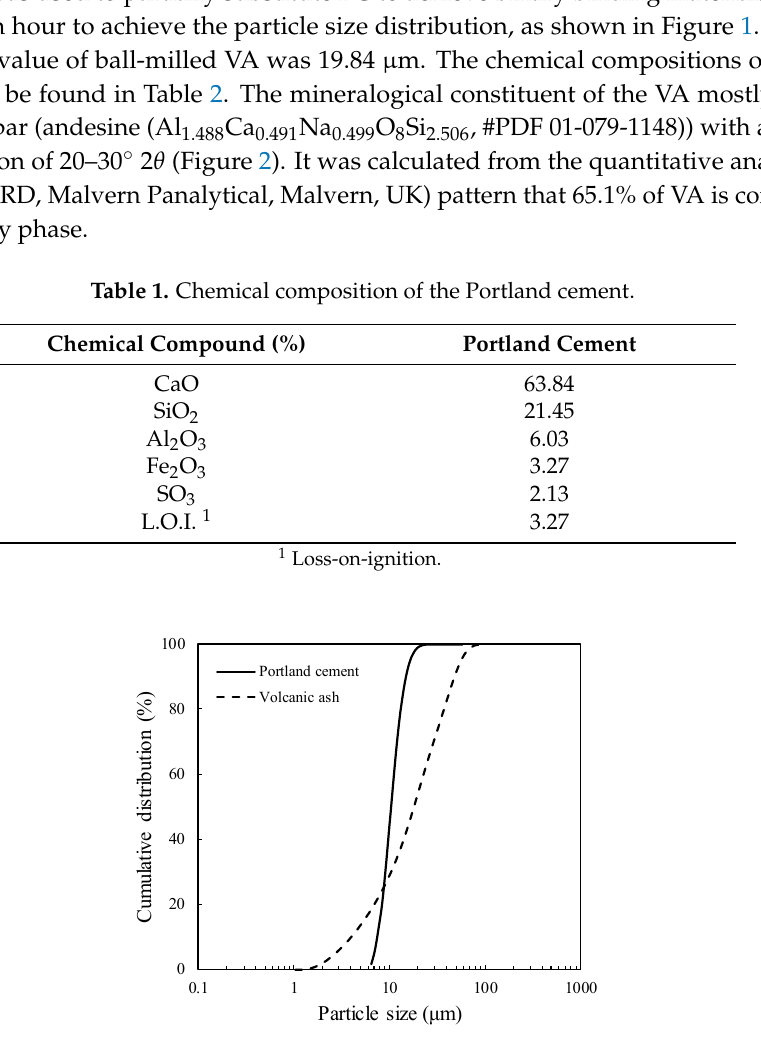
Figure 1. Particle size distribution of Portland cement and volcanic ash. Table 2. Chemical composition of the volcanic ash.